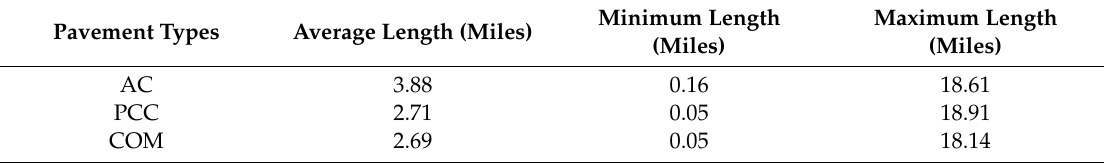
Table 2. Threshold values for the cracking sub-indices.